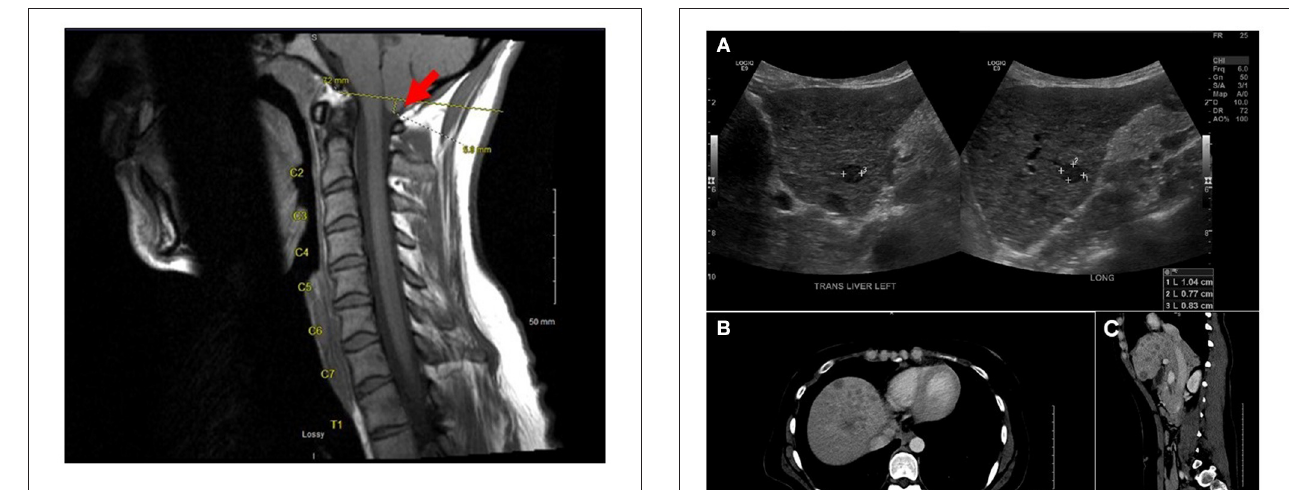
FIGURE 1 | A magnetic resonance imaging of the cervical spine showing a Chiari I malformation (red arrow) with a 5.8mm displacement of the cerebellar vermis through the foramen magnum.